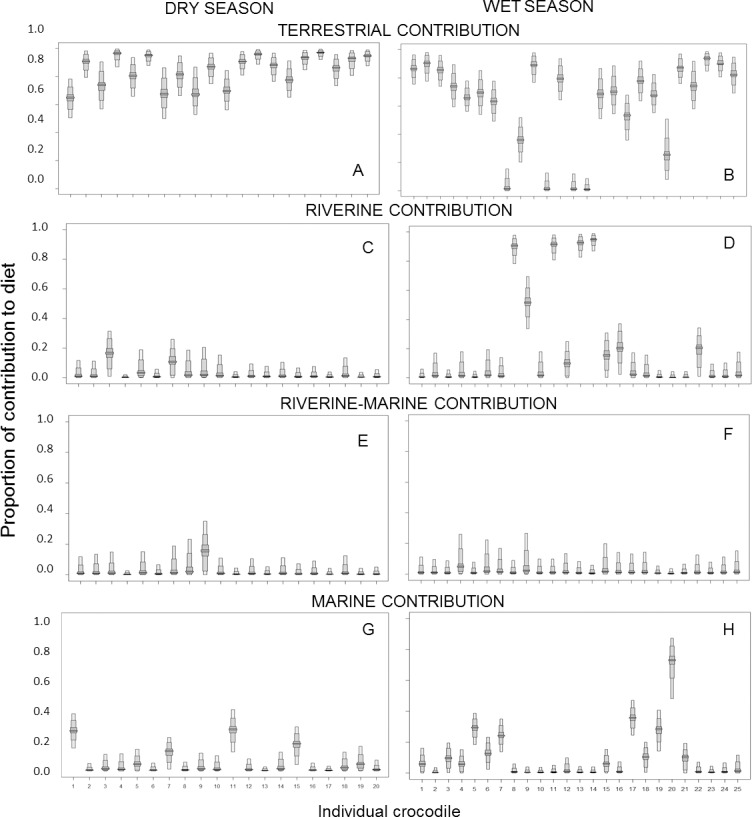
Proportion of contribution of prey to the nutrition ofestuarine crocodiles in Kakadu National Park.Crocodiles were caught during the dry and wet season and isotope values were analysed with SIAR solo. Terrestrial prey includes water buffalo, pigs and wallabies; riverine prey is represented by mullet; riverine-marine prey is represented by barramundi and marine prey is represented by giant sea catfish. Box plots represent the 5, 25, 75 and 95% credibility intervals.